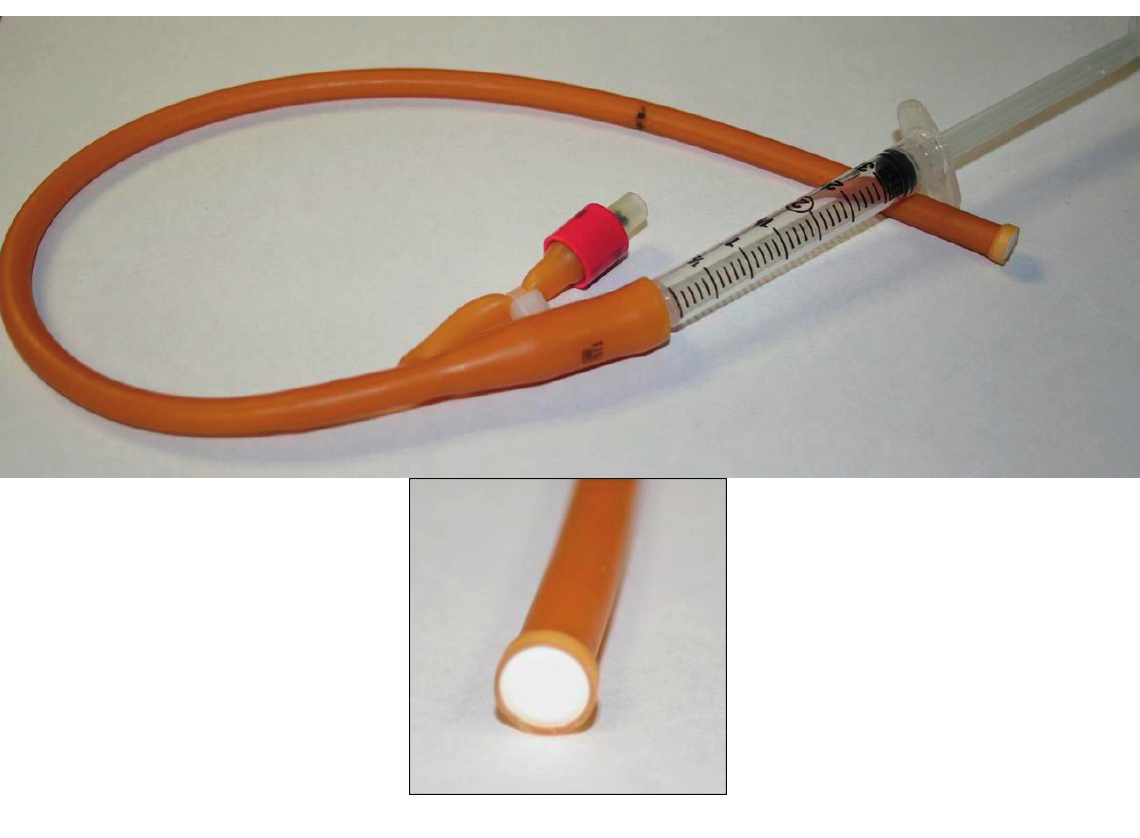
Figure 1. Tablet dosing apparatus; Inset: tablet loaded in tip of device. The apparatus is constructed from a modified Foley catheter (18 or 20 French). After insertion into the abdominal vagina (~8 cm, distance marked by black line on catheter), the tablet is released from the device using gentle air pressure generated by an attached disposable